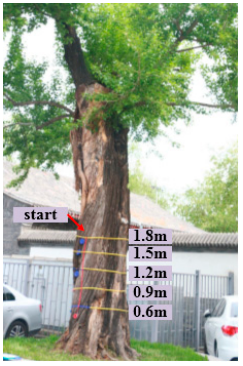
Figure 4. Sketch map of detection.